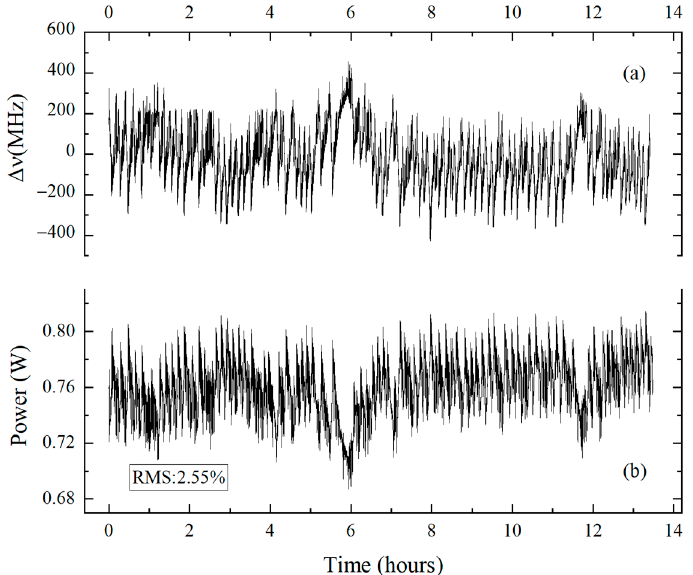
Figure 9. Measured signal frequency ( a ) and idler power ( b ) stability over 13 h.